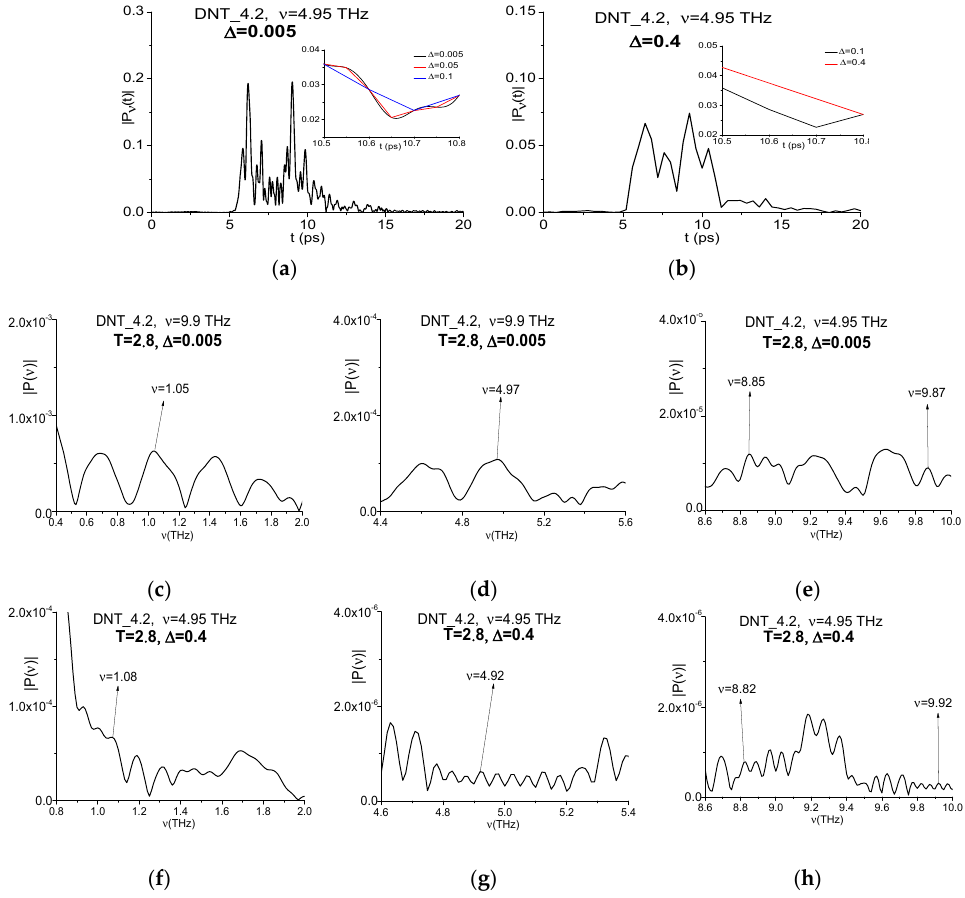
Figure A4. 2,4-DNT spectral line dynamics computed at the frequency ν = 4.95 THz at the window shift ∆ = 0.005 ps ( a ) and 0.4 ps ( b ) (with magnified view). Spectra of the spectral line dynamics computed at the window shift ∆ = 0.005 ps ( c – e ), 0.4 ps ( f – h ) in the frequency ranges ν = [0.4, 2.0] THz ( c ), [0.8, 2.0] THz ( f ), [4.4, 5.6] THz ( d ), [4.6, 5.4] THz ( g ), and [8.6, 10.0] THz ( e , l